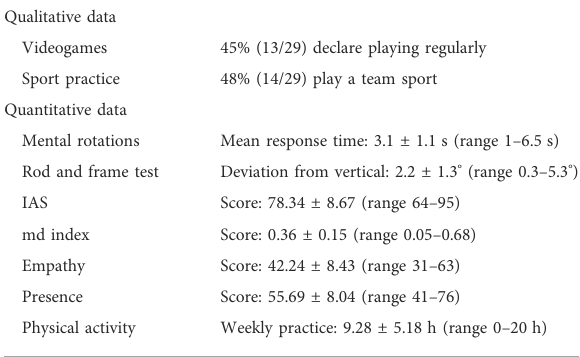
TABLE 3 Results from questionnaires and pre-tests. Quantitative